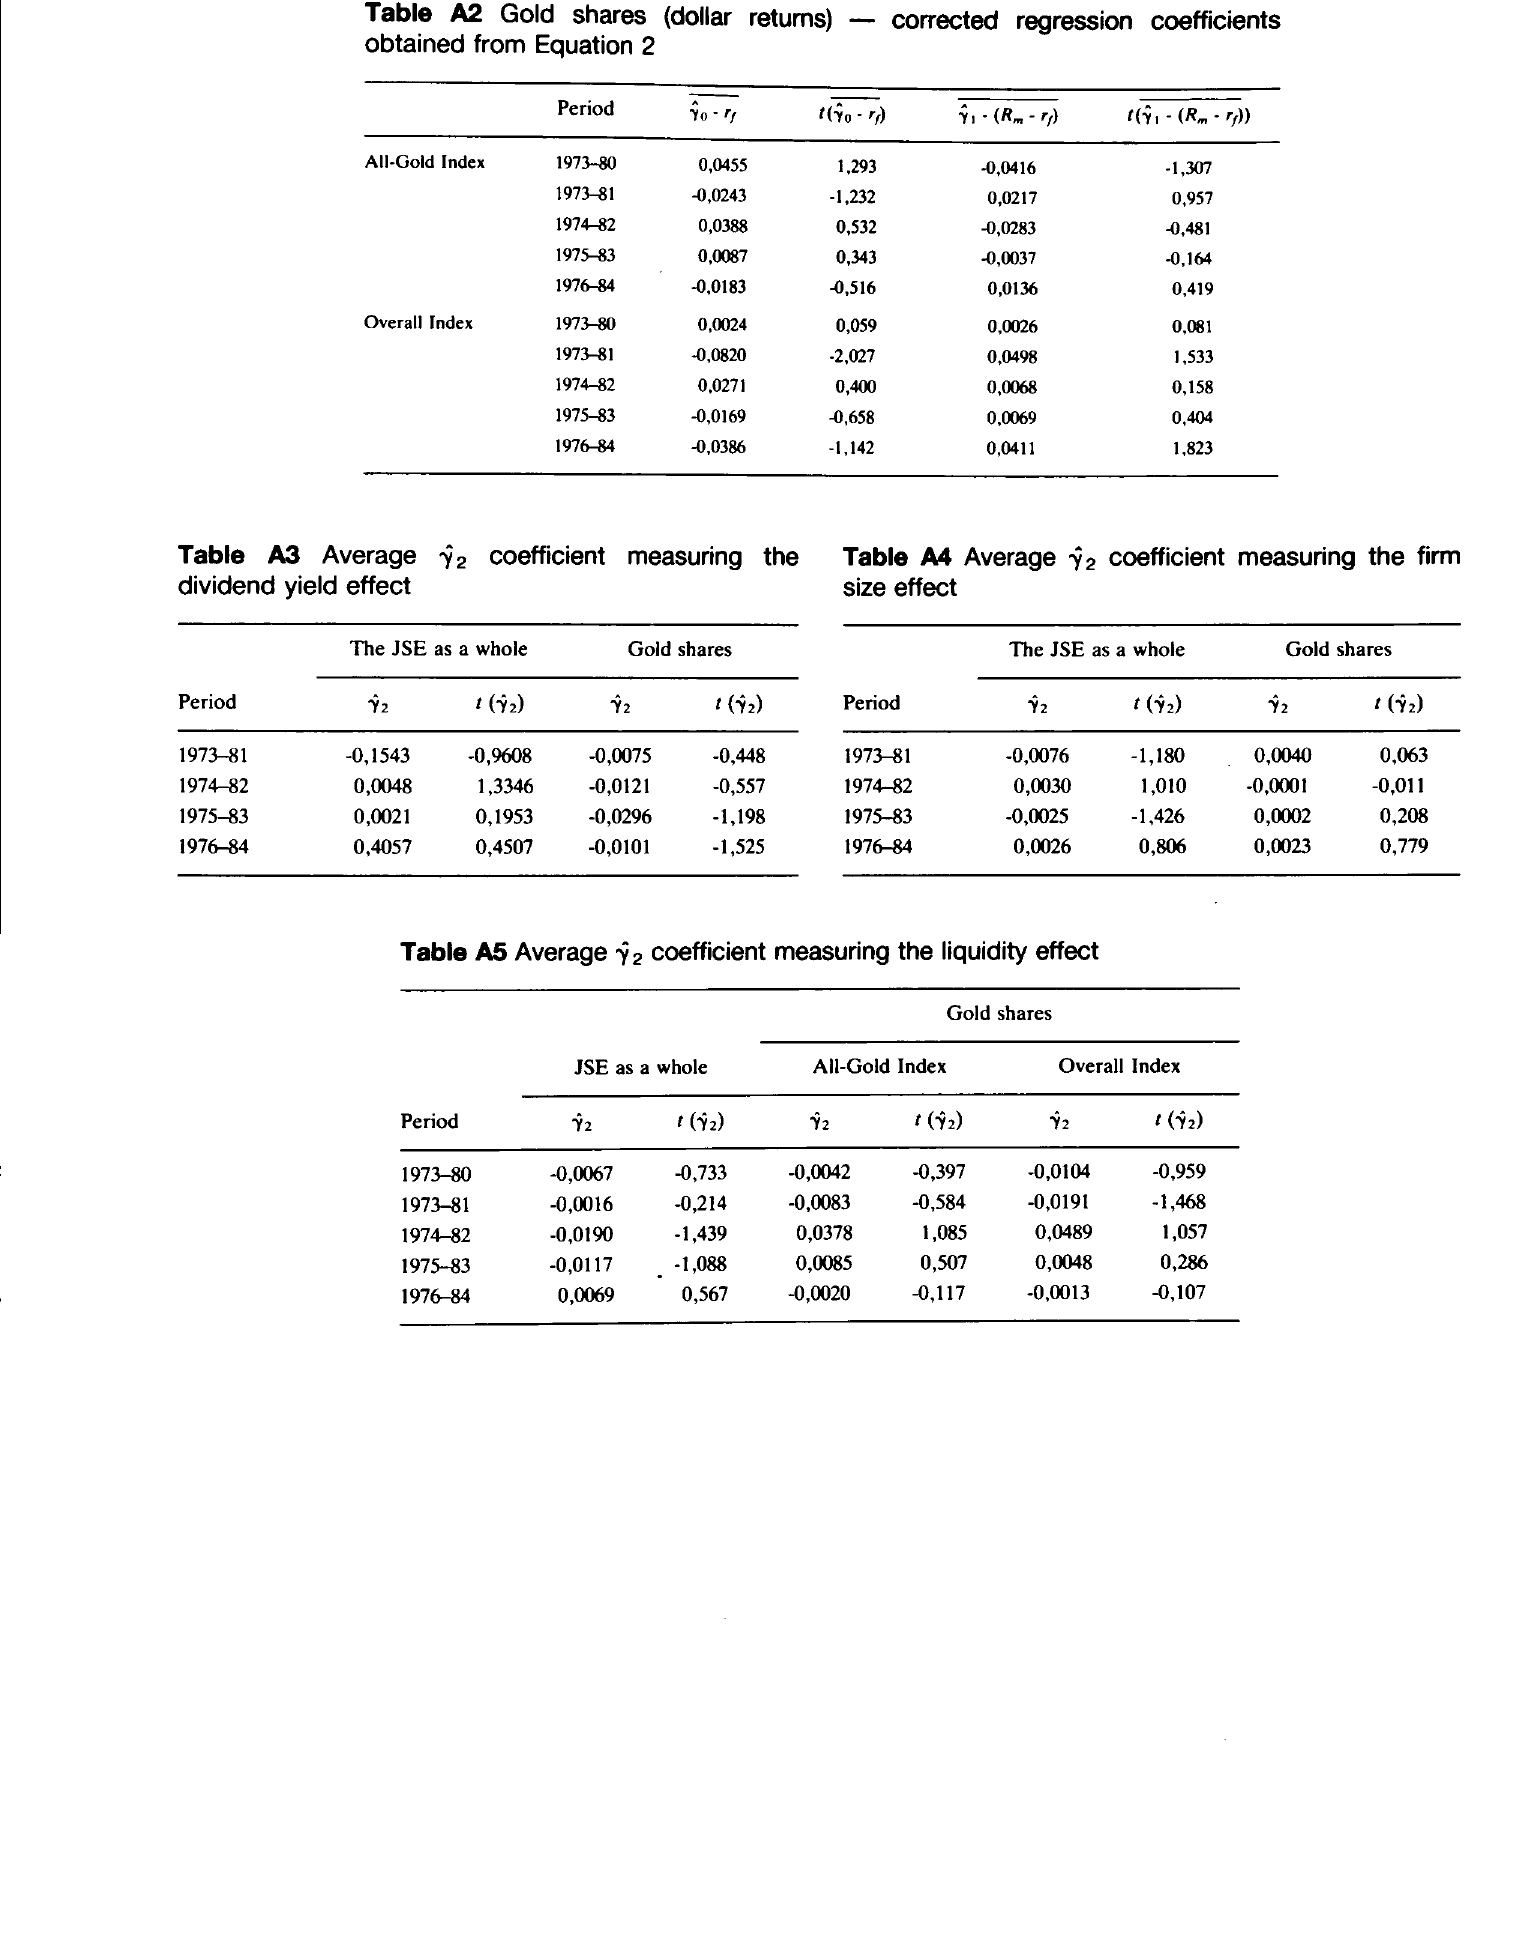
Table A3 Average 'Y 2 coefficient measuring the Table A4 Average -y